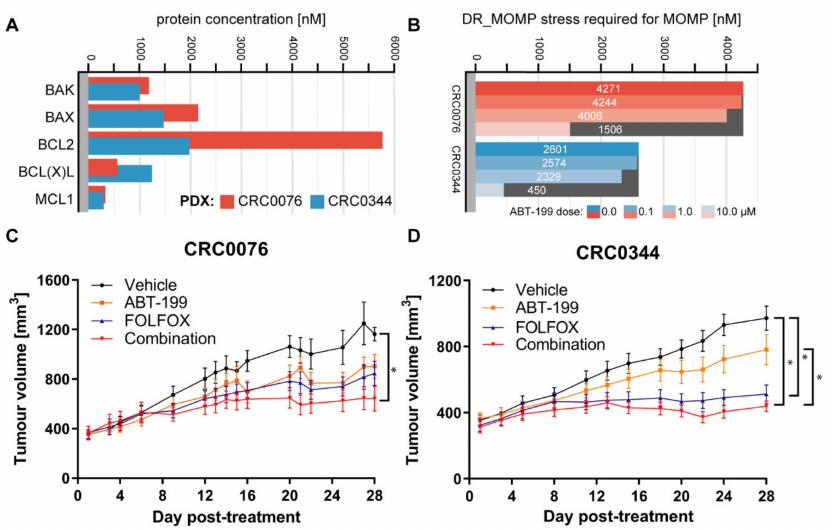
Figure 2. DR_MOMP successfully predicated the sensitivity of two CRC PDXs to treatment with FOLFOX and ABT-199 in combination. ( A ) Two mCRC PDXs (CRC0344 and CRC0076) were assessed for BCL-2 family proteins levels by quantitative Western blot (Figure S3). ( B ) The susceptibility of each model to undergo MOMP in response to genotoxic chemotherapy alone or in combination treatment with ABT-199 was calculated using DR_MOMP. ( C , D ) Anti-tumour activity of ABT-199 alone and in combination with FOLFOX chemotherapy in the two models was assessed in vivo. Mice bearing either a CRC0076 or CRC0344 tumour were treated with vehicle control, ABT-199 100 mg / kg, FOLFOX or the combination ABT-199 + FOLFOX; n = 13–14 / group, error bars = s.e.m., * p ≤ 0.05. The e ff ect of treatment on absolute tumour volumes of the predicted combination only responder CRC0076 and the predicted FOLFOX alone responder CRC0344 PDX models are shown respectively ( C , D